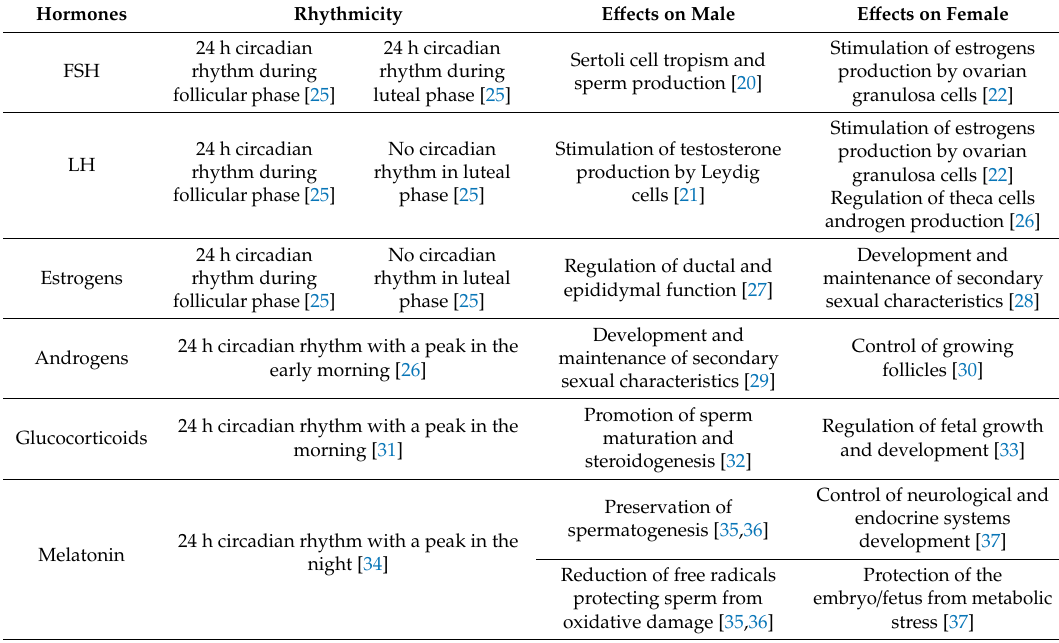
Table 1. Rhythmicity and physiological e ff ects of hormones in male and female